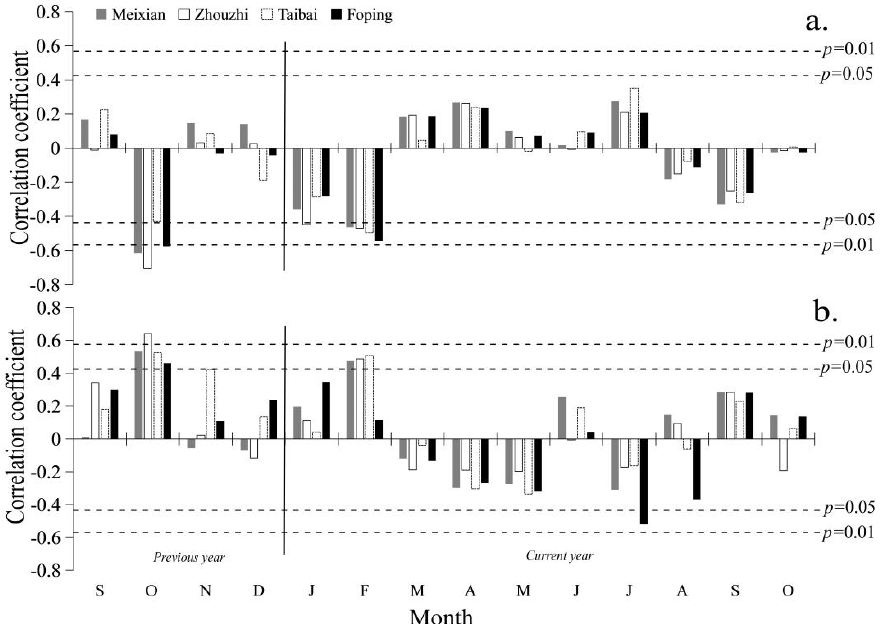
Figure 5. Correlation between TBM NDVI and residual chronology (RES) ( a ). Relationship between July NDVI and residual chronology (RES) during their common period of AD 1991–2013 ( b ).